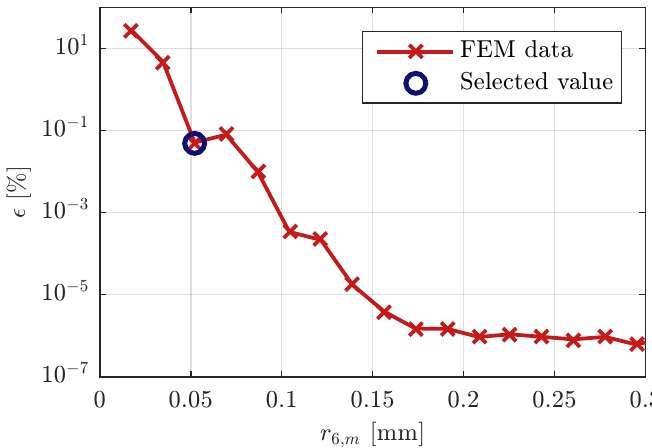
Figure 3. Absolute value of the relative error with respect to the reference ( (cid:101) ) as a function of the modeled radial thickness of the conductive cylinder ( r 6, m ), including the indication of the selected